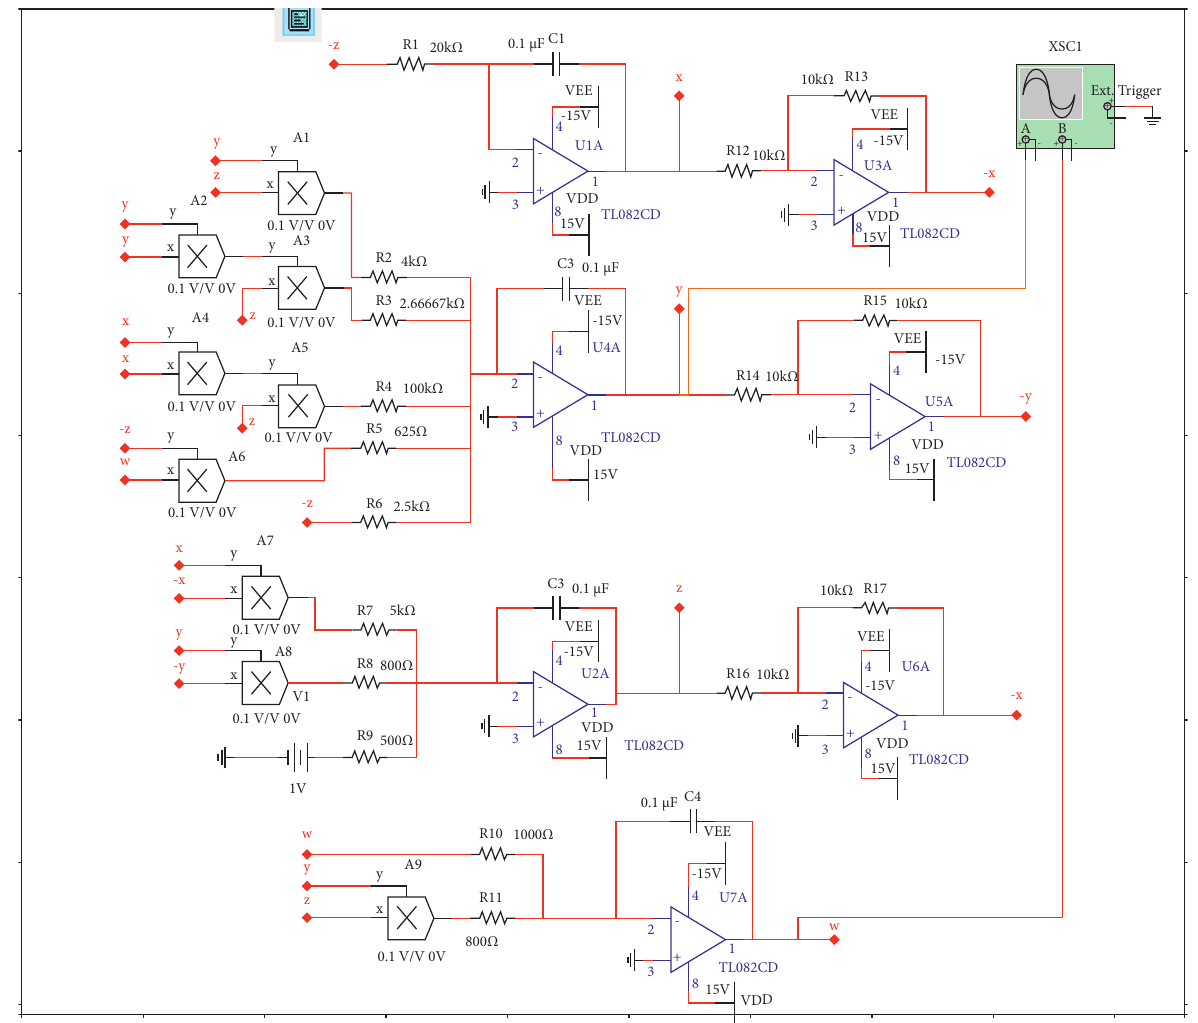
Figure 10: Circuit diagram of the chaotic